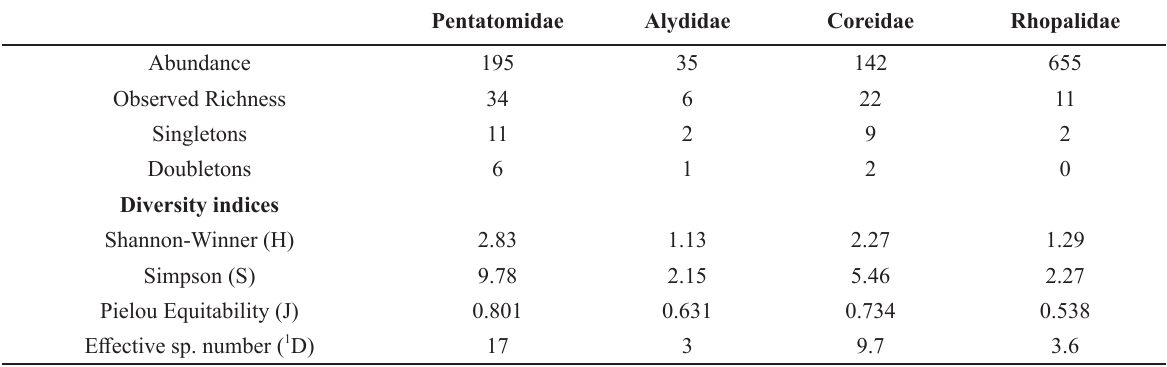
Inventory data and diversity indices comparing the four families studied in Parque Provincial Moconá.